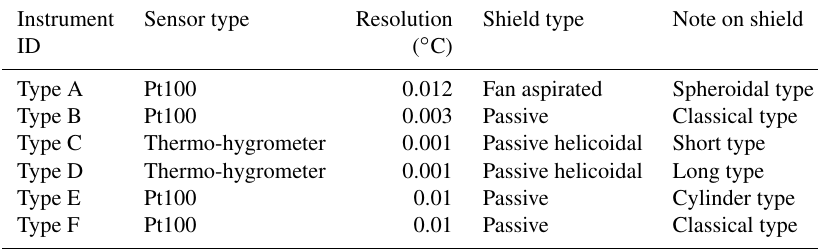
Table 1. Selected air temperature instruments and their main characteristics.